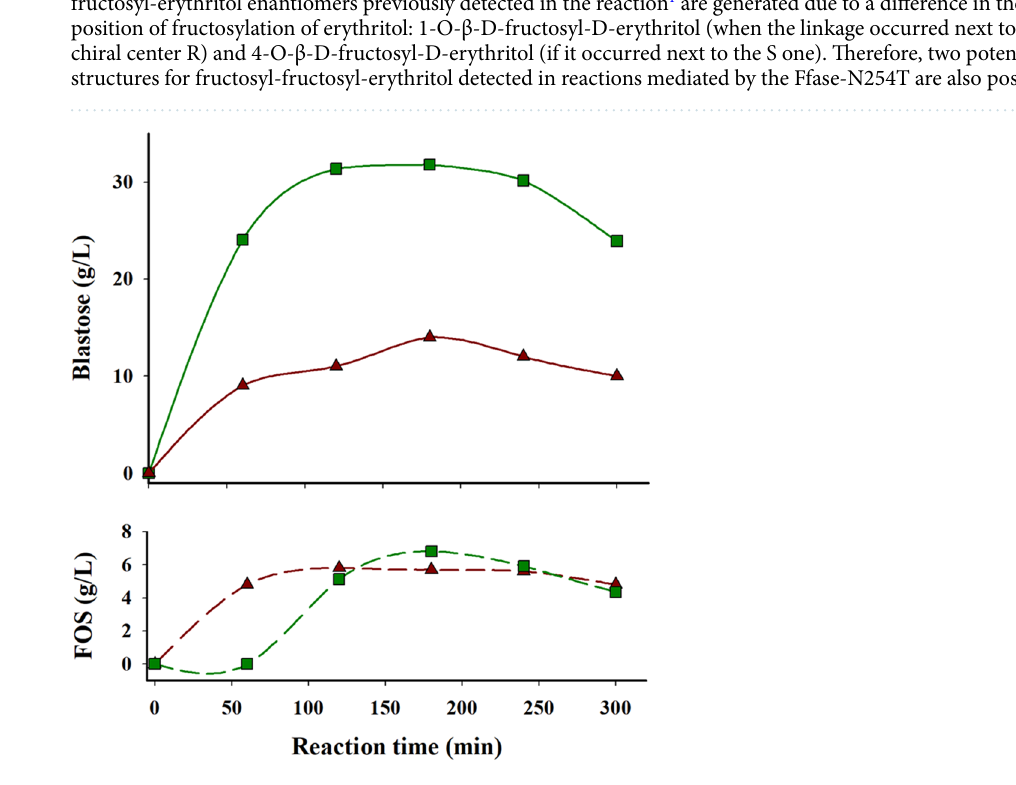
Figure 5. Time-course of the reaction mediated by the wild-type Ffase and N254T variant using glucose as alternative fructosyl-acceptor. Data from native Ffase and Ffase-N254T are represented in brown triangles and green squares, respectively. FOS for the wild-type enzyme were 6-kestose and 1-kestose; while for the N254T variant were neokestose and 6-kestose. Reaction mixtures (1.5 ml) incubated at 50 ºC contained 10 U ml −1 of the purified enzymatic variants, 200 mg ml −1 sucrose, and 600 mg ml −1 glucose in 0.1 M sodium acetate pH 5.5. The constituents of the reaction mixtures were quantified in duplicate at the indicated times by HPLC-ELSD with standard deviation less than